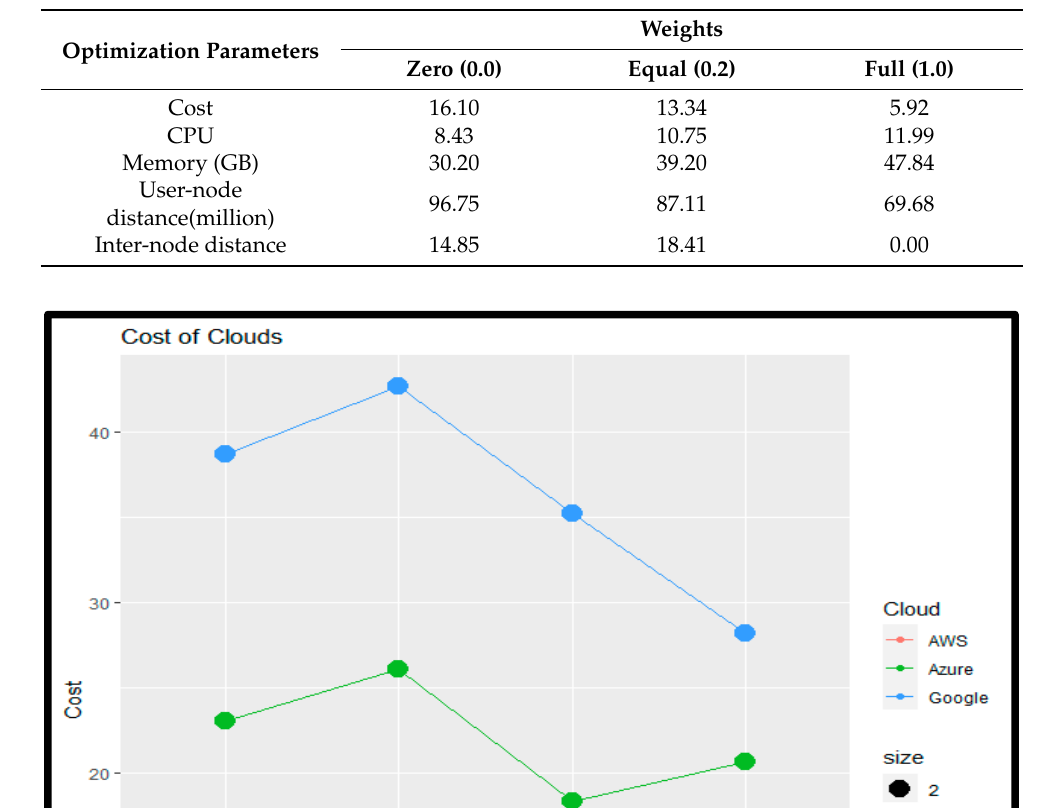
Table 8. Parameter values for various weights [41].